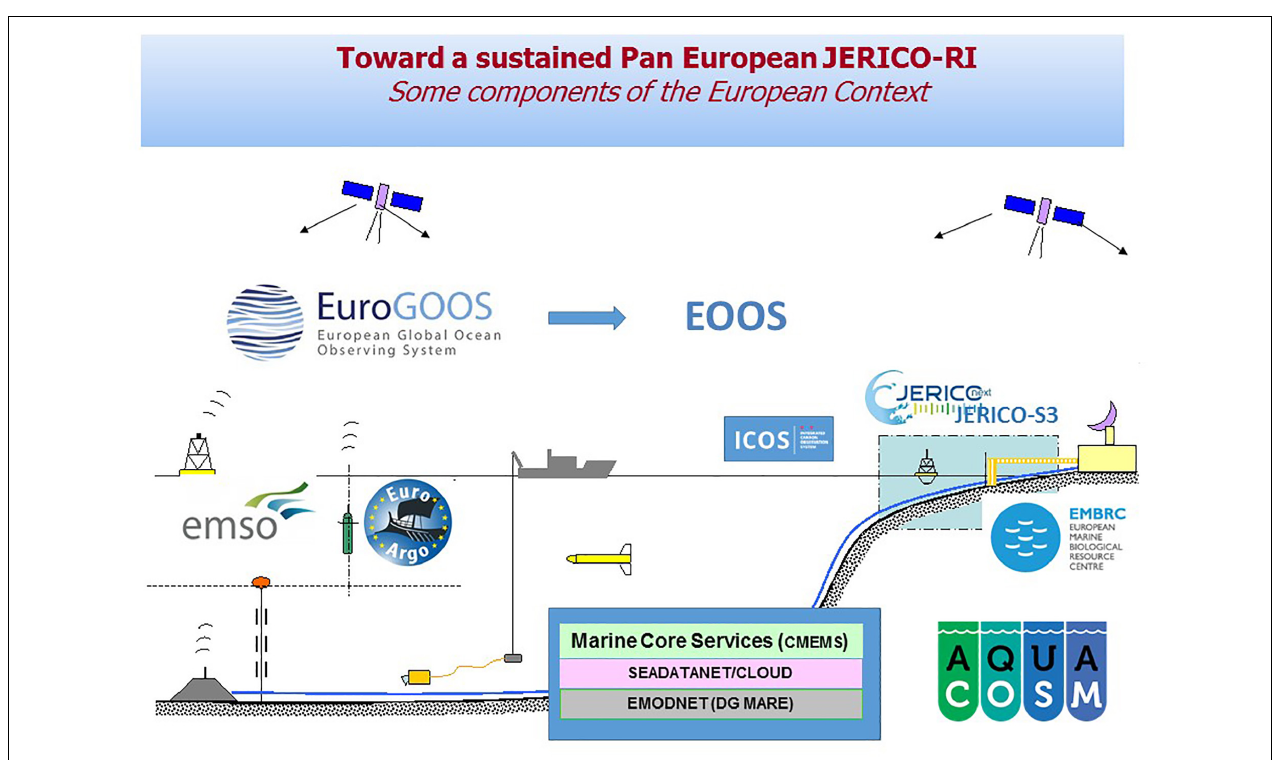
FIGURE 3 | Possible future positioning of JERICO-RI as the coastal component of an emerging European coastal Ocean Observing System.